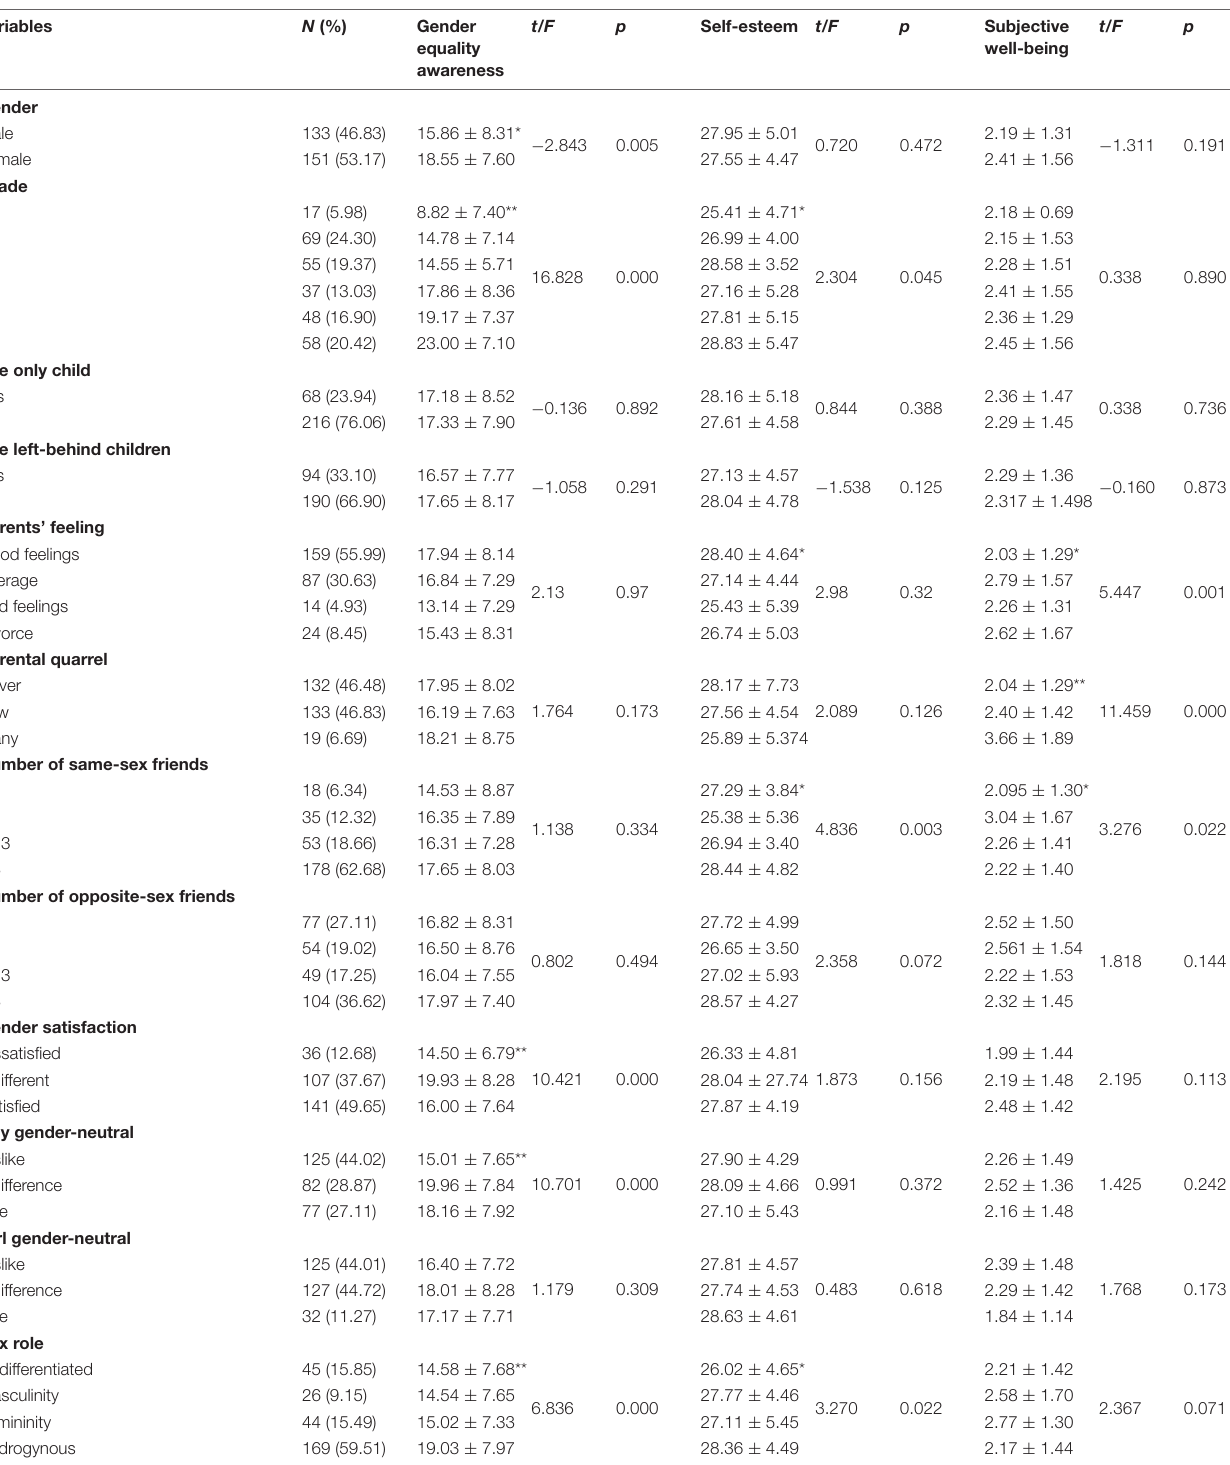
TABLE 1 | Relationships among socio-demographic characteristics and variable scores ( N = 284).